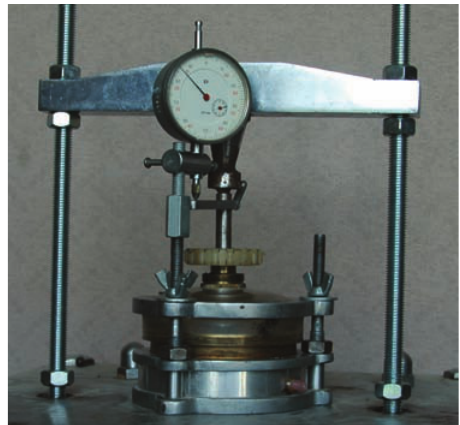
Fig. 2. Oedometric